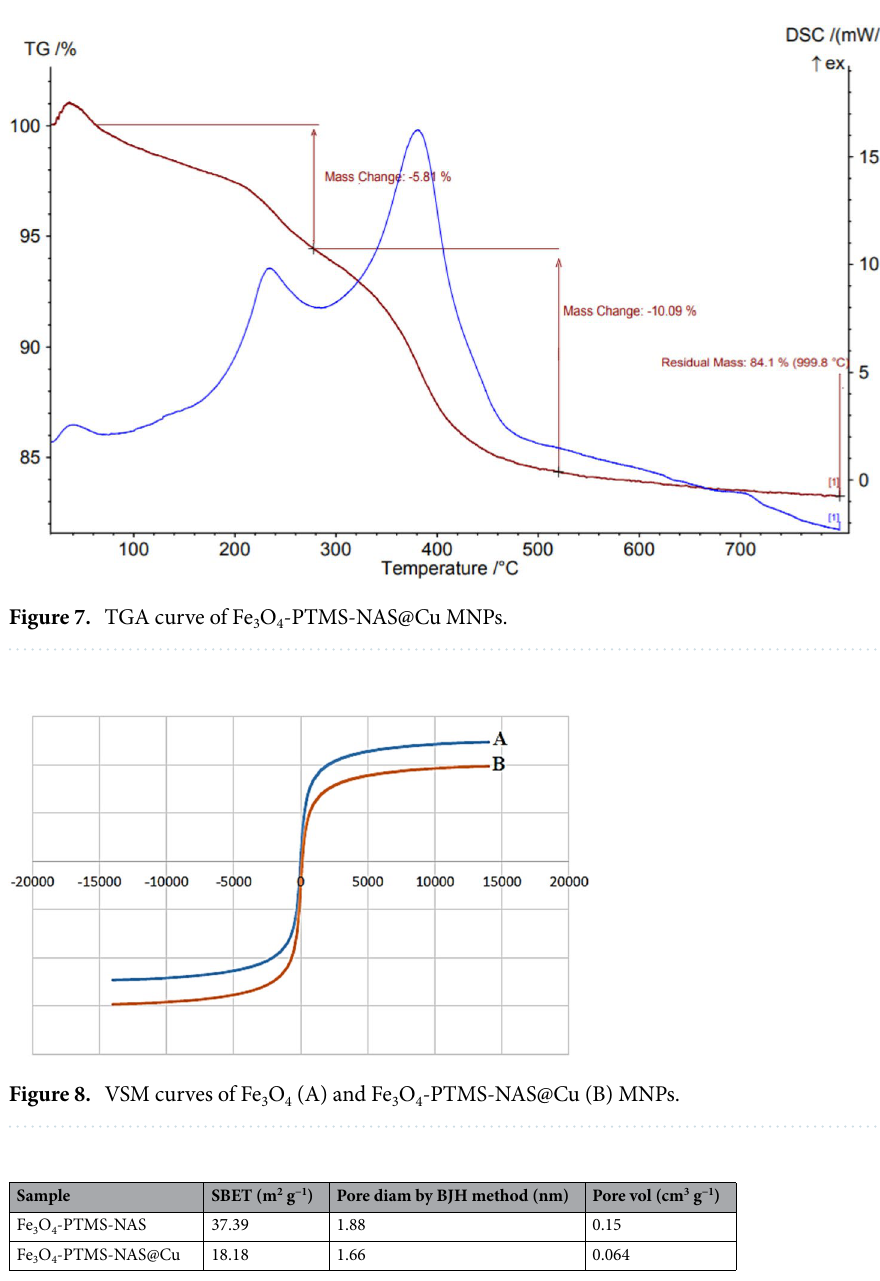
Table 1. Textural properties of Fe 3 O 4 -PTMS-NAS and Fe 3 O 4 -PTMS-NAS@Cu.